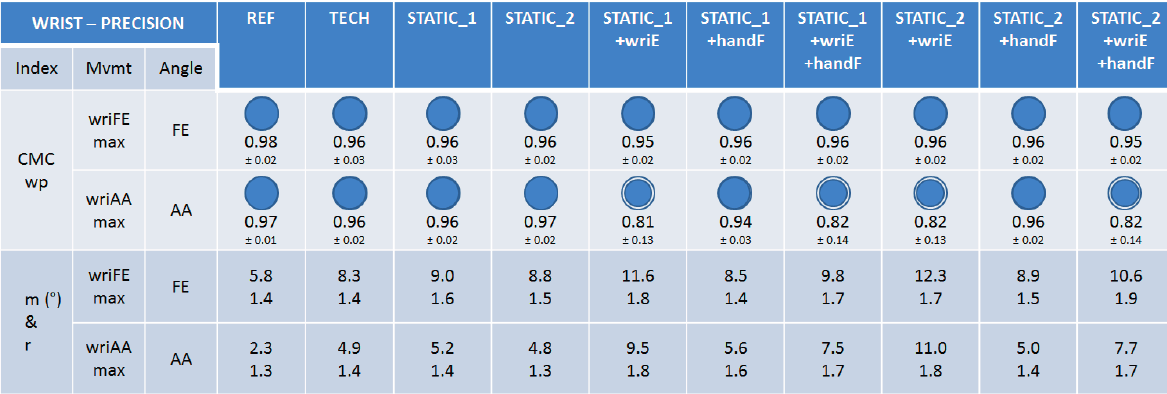
Figure 6. The results on precision for the wrist joint. CMCwp, m , and r values are reported for the different calibrations and for the REF method during maximal wrist flexion-extension (wriFEmax) and abduction-adduction (wriAAmax). For visual clarity, the mean value of the CMCwp is completed with a proportional blue disc included in a blue circle that represents the optimal value